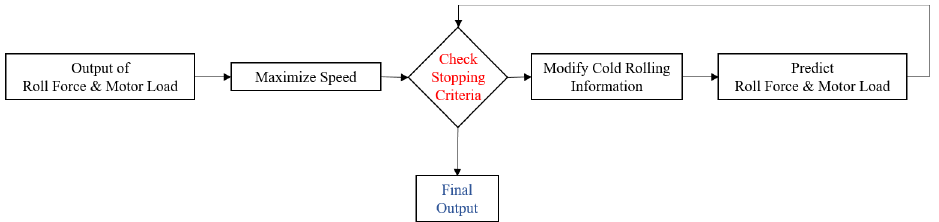
Figure 6. Procedure of the motor load balancing